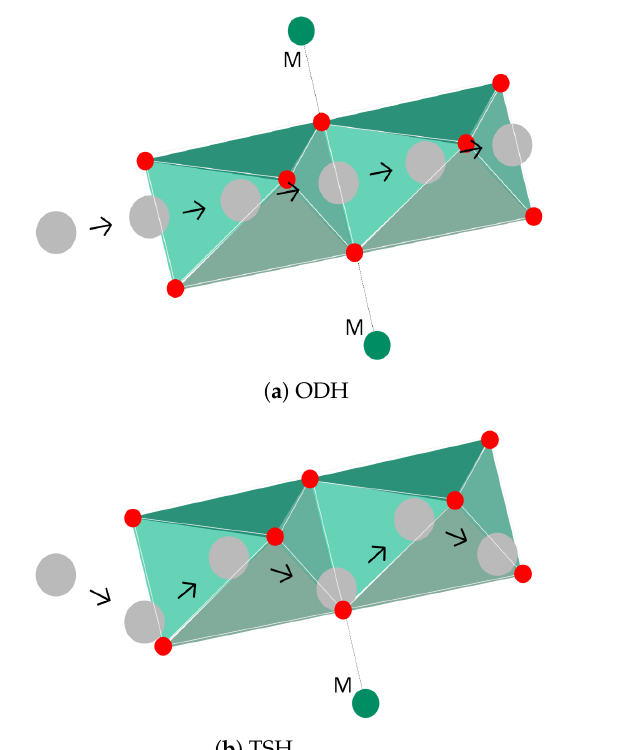
Figure 5. Li-ion diffusion mechanisms in layered oxides: oxygen dumbbell hopping (ODH) and tetrahedral site hopping